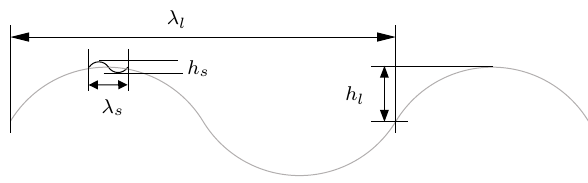
Figure 1. Profile of the two-scale sea surface